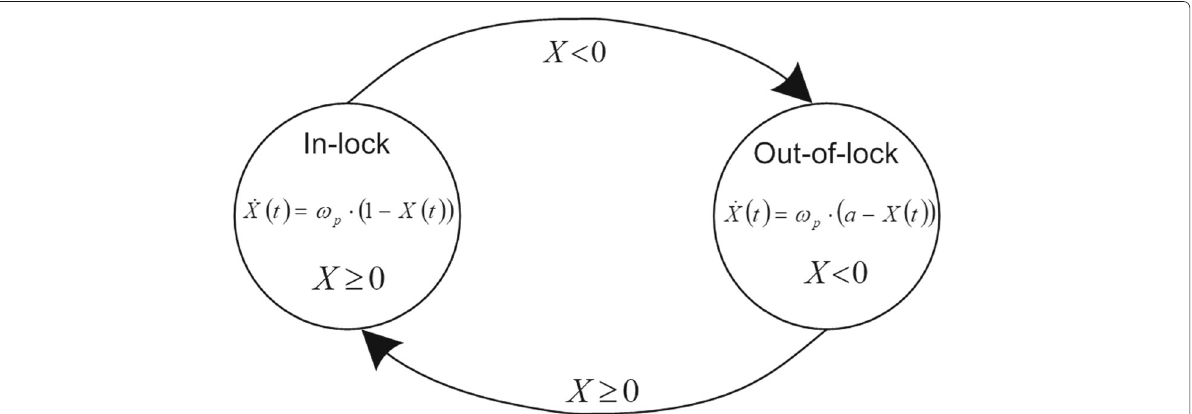
Fig. 5 The closed-loop mathematical model as switched system. The loop is stable when the correct detection is the unique statistical equilibrium